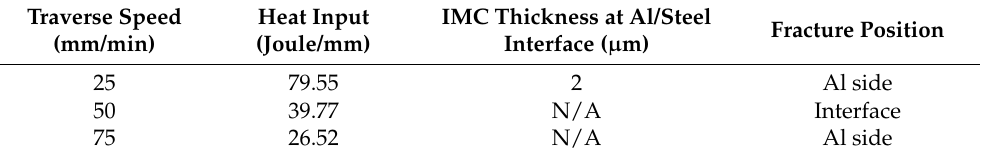
Figure 10. Stress–strain curves obtained by tensile test for the FSWed joints welded at ( a ) various rotation speeds; ( b ) various traverse speeds. Table 4. Shows a mount of heat input, IMC thickness and fracture position for each rotation speed. Table 5. Shows the amount of heat input, IMC thickness and fracture position for each traverse